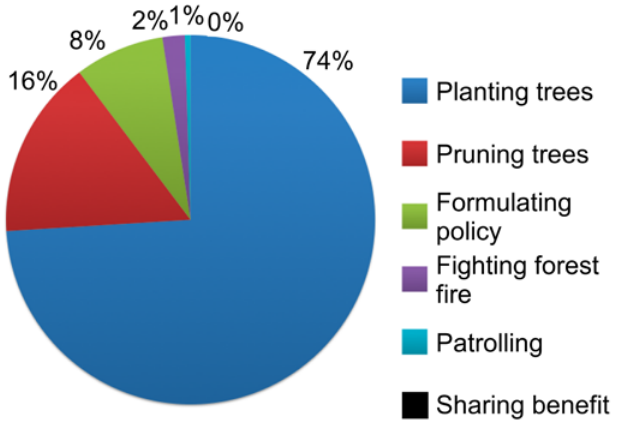
Figure 11. Activities carried out by CFA members as of 2015, identified by the questionnaire survey ( n = 204).